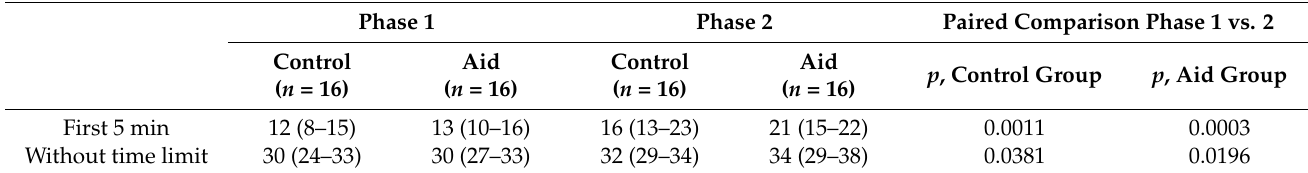
Table 2. Number of essential items (out of a possible total of 40 items) validated by residents in the first 5 min and without time limit in both phases.